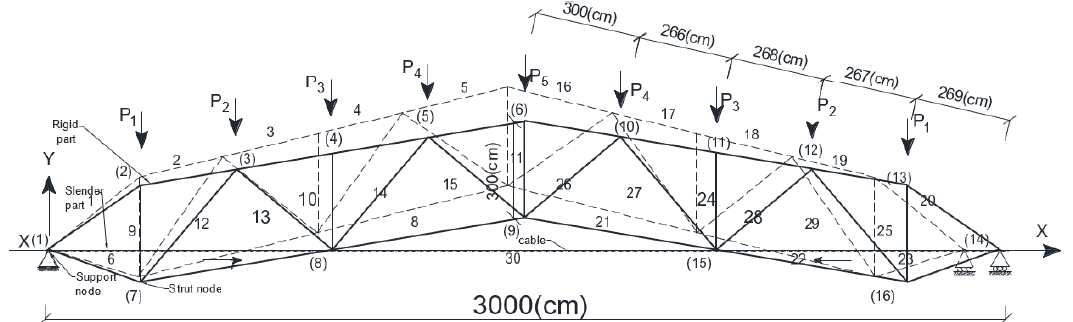
Figure 5. A new type of prestressed arched truss with a cable (tie member).